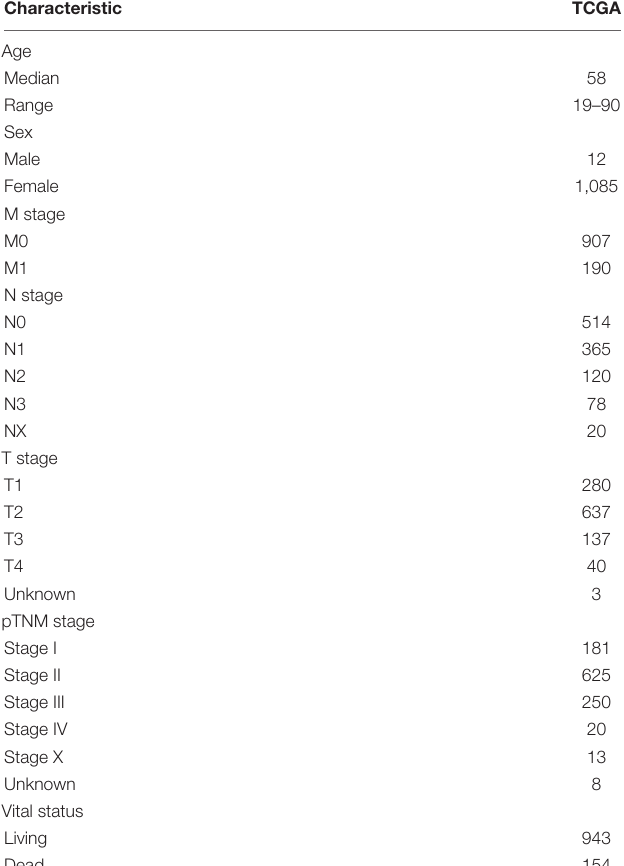
TABLE 1 | Clinical characteristics of BRCA patients in